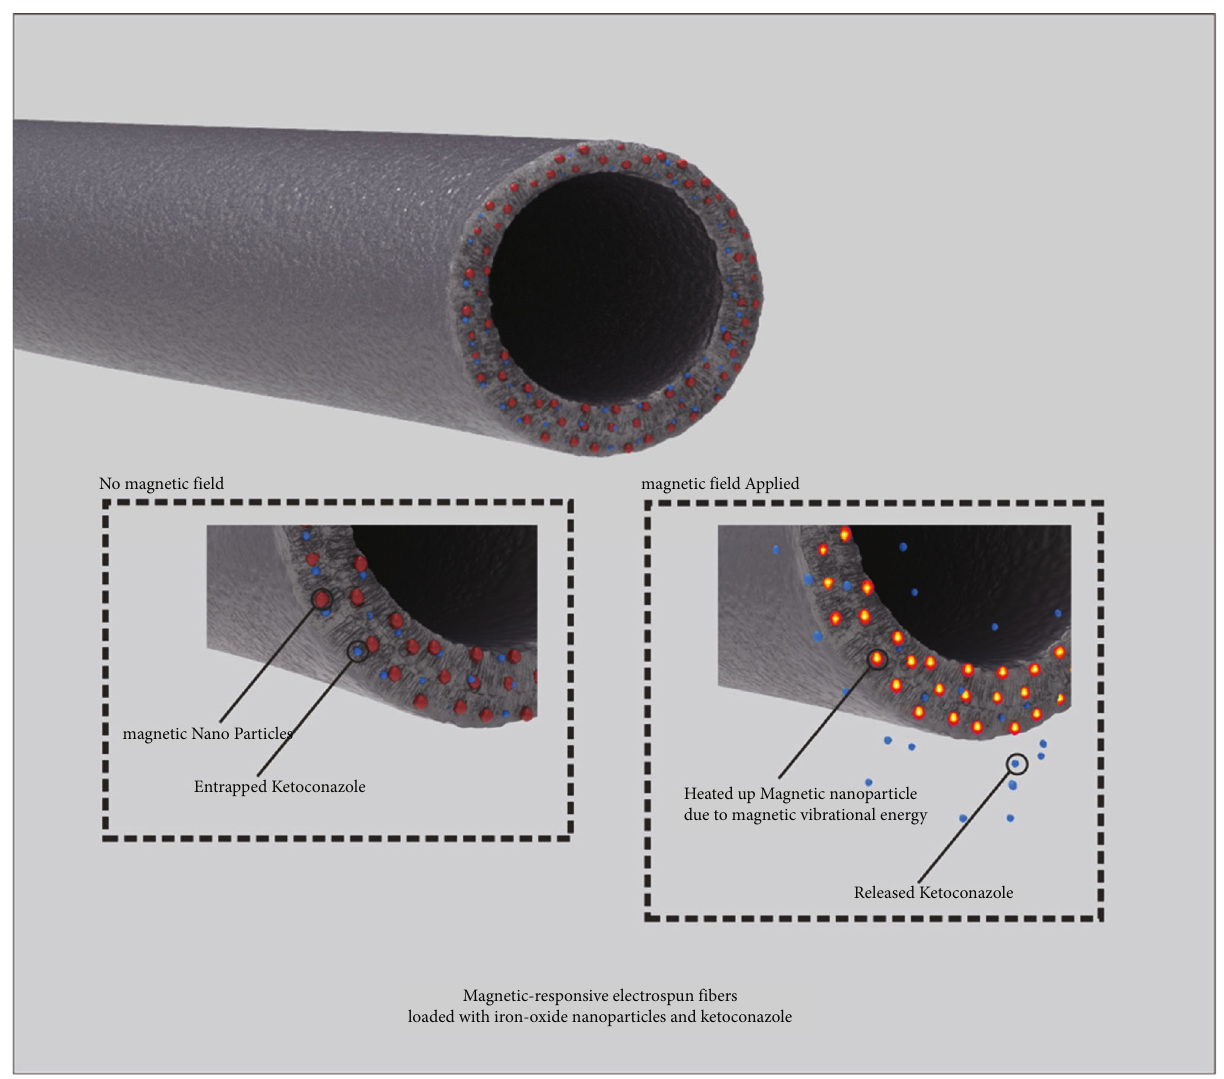
Figure 7: Release of ketoconazole from magnetic-responsive fi bers